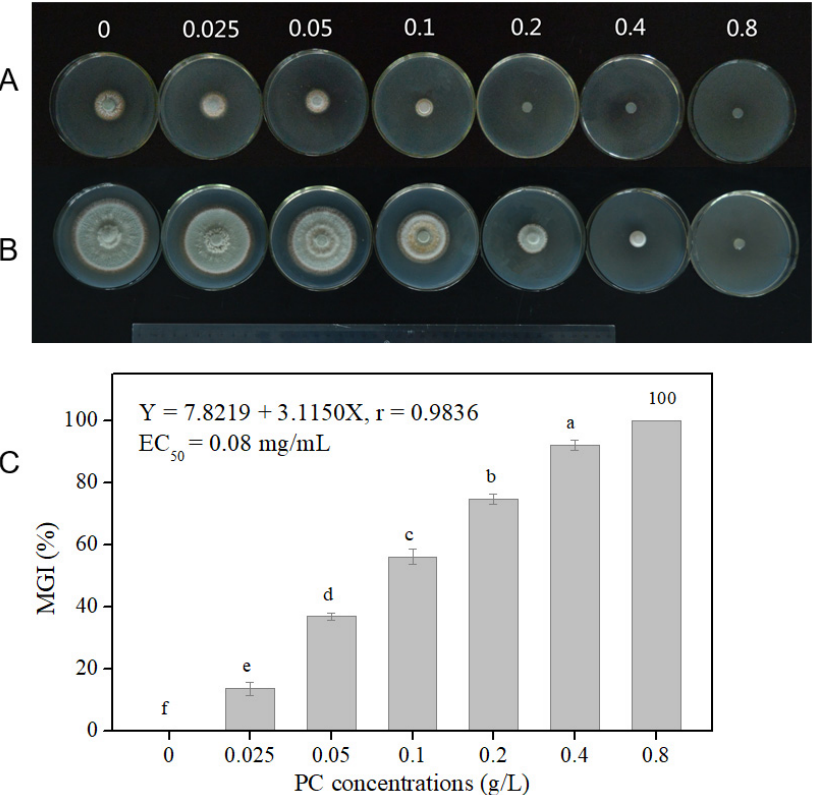
Figure 2. The minimal inhibitory concentration (MIC), the minimum fungicidal concentration (MFC) and the inhibitory effect of P7G against P. italicum on the second day ( A ), sixth day ( B ), and seventh day ( C ) after inoculation. Different letters (a–f) at each interval in Figure 1 C indicate significant differences at p < 0.05 according to Duncan’s test.